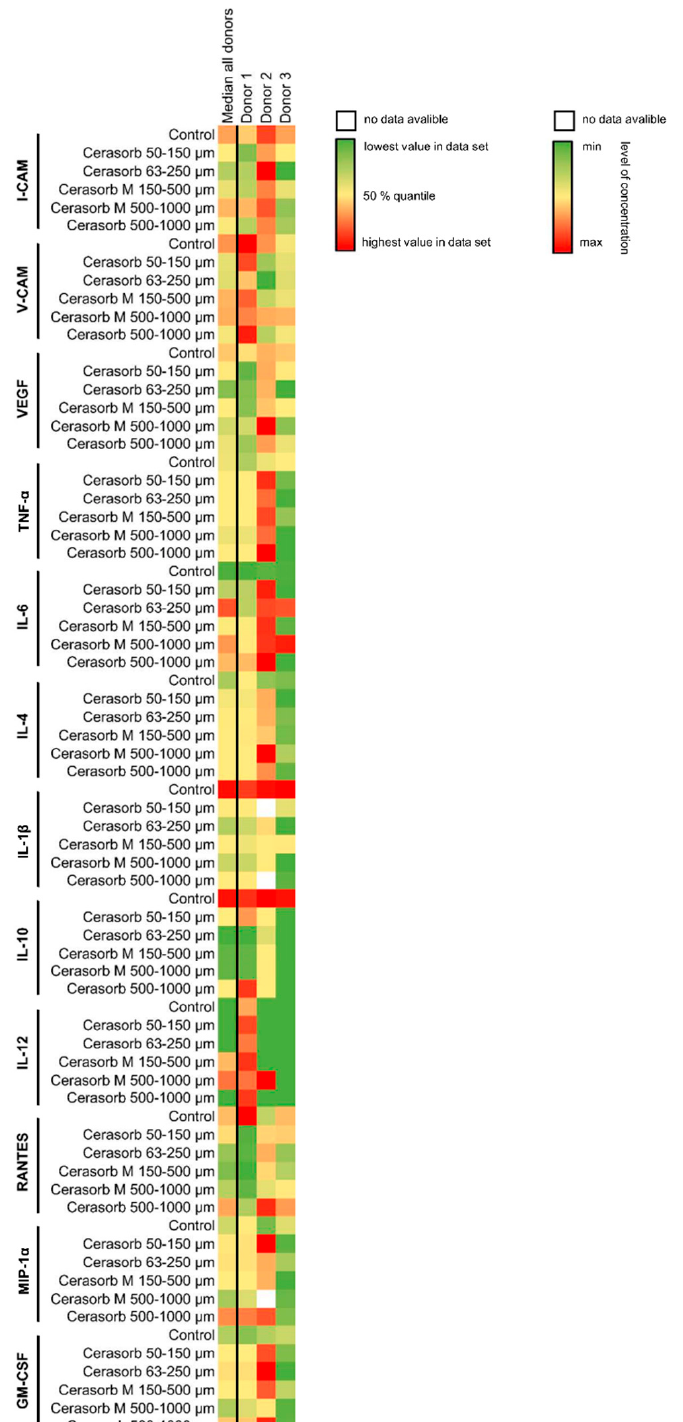
Figure 4. Heat Map of cytokines expressed by the monocytes. The median cytokine concentrations of each donor and the overall median are displayed for each analyzed cytokine. A green stain shows the lowest concentration, a yellow stain the 50% quantile and the red stain the highest concentration of each analyzed cytokine. A white square is shown, if the measured concentration was out of range during the measurement.